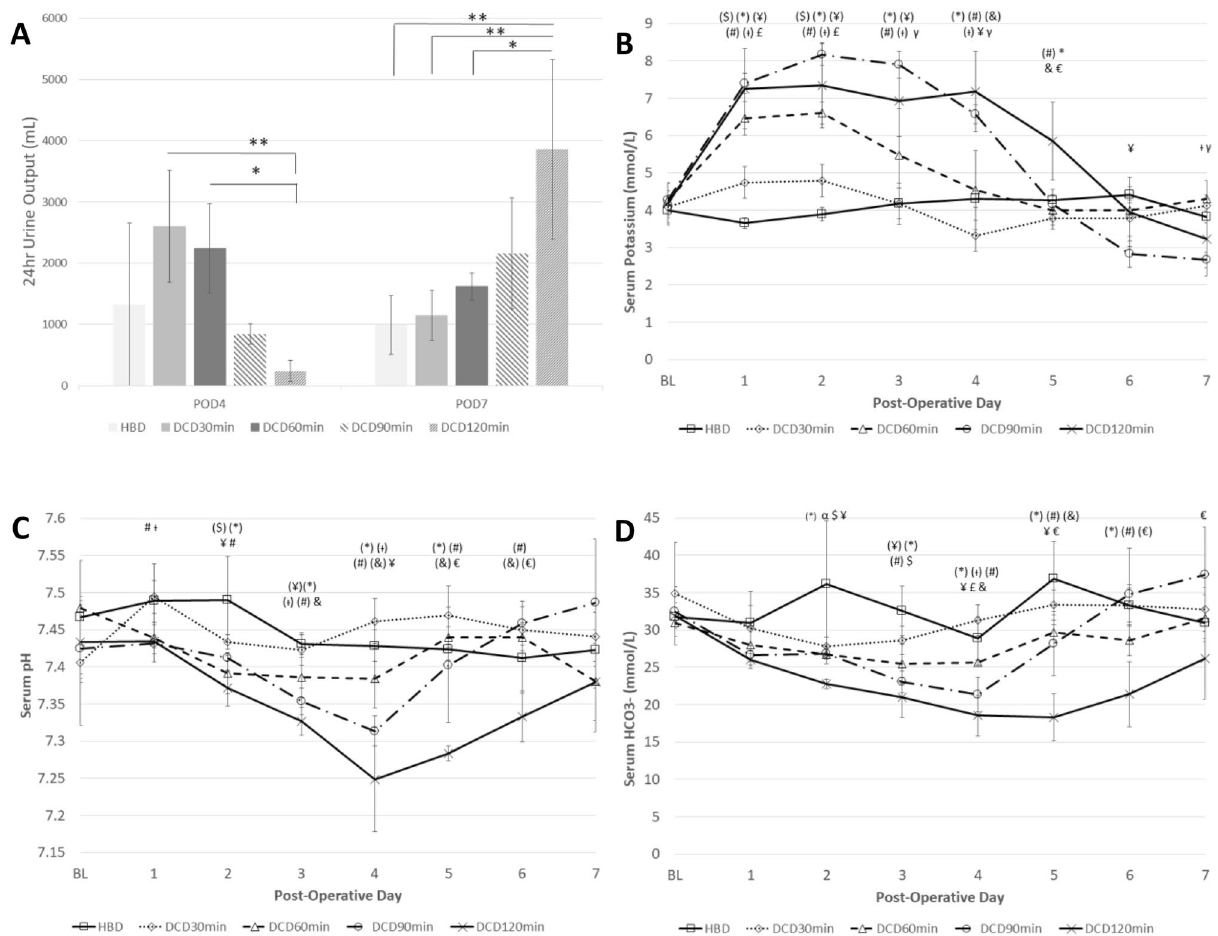
Figure 4. Biochemical characteristics of HBD and DCD kidneys ( A ) POD4 and 7–24 h urine output (mean +/− standard deviation, * p < 0.05 ** p < 0.01). ( B – D ) Post-operative serum electrolyte and acid–base regulation including ( B ) Serum Potassium. ( C ) Serum pH and ( D ) Serum bicarbonate levels. Values are expressed as mean +/− standard deviation. Statistical difference p < 0.05 with α: HBD vs DCD30min, $: HBD vs DCD60min, ¥: HBD vs DCD90min, *: HBD vs DCD120min, £: DCD30min vs DCD60min, †: DCD30min vs DCD90min, #: DCD30min vs DCD120min, γ:DCD60min vs DCD90min, &:DCD60min vs DCD120min, €:DCD90min vs DCD120min. In brackets: p < 0.01. POD Post-Operative Day, pH power of Hydrogen, HCO3 Bicarbonate, HBD Heart Beating Donor, DCD Donation after Cardiac